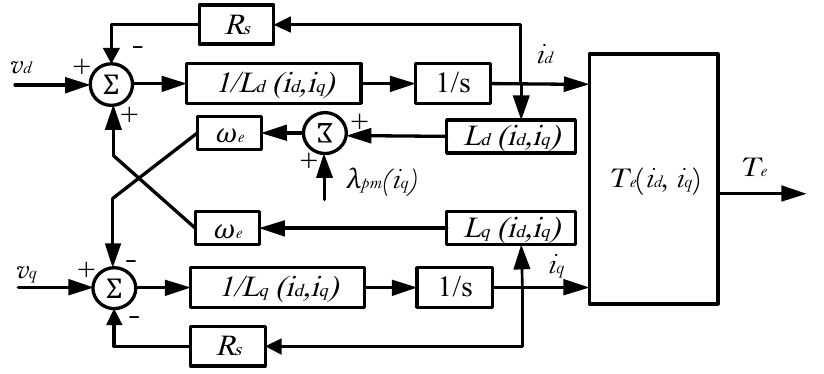
Figure 1. The schematic of the conventional machine model.